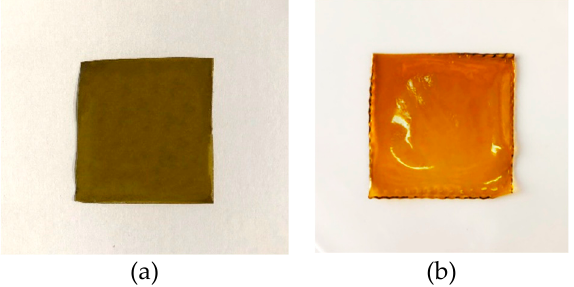
Figure 3. AFA100 ( a ) and AFA300 ( b ) matrix films.